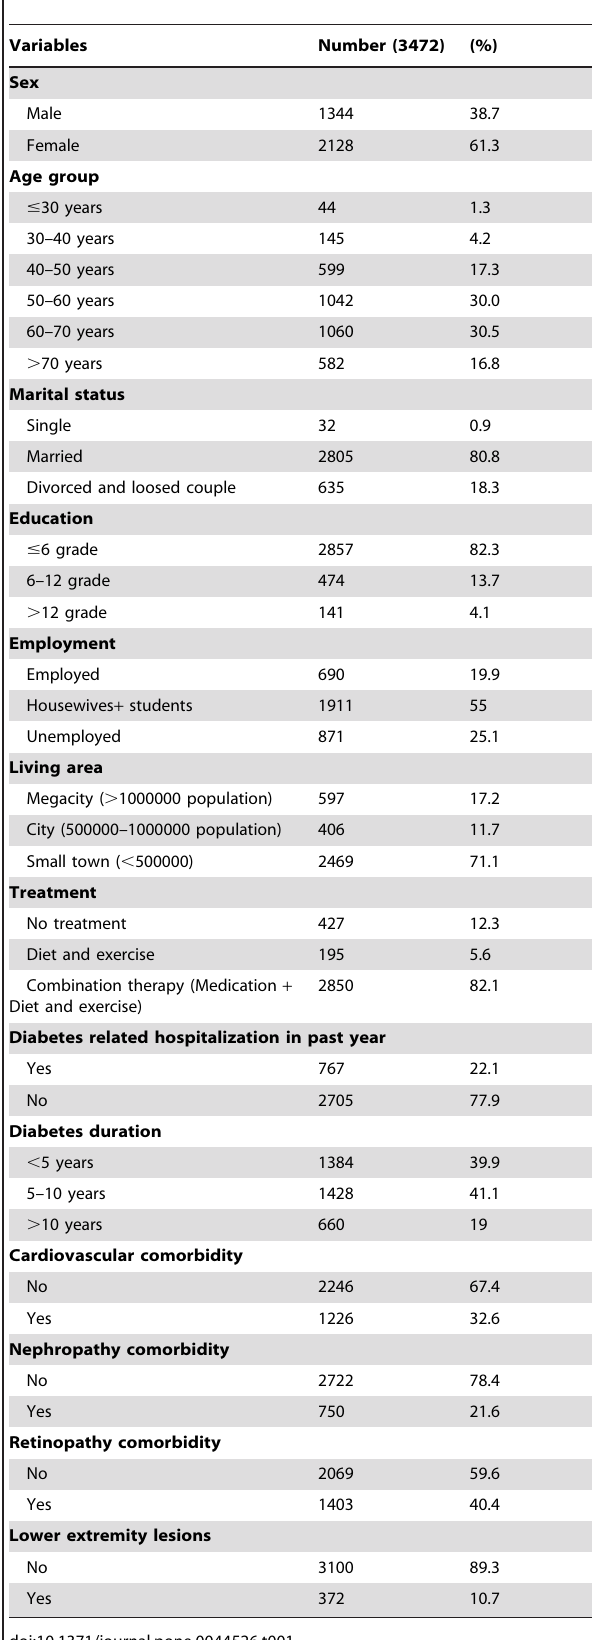
Table 1. Characteristics of the